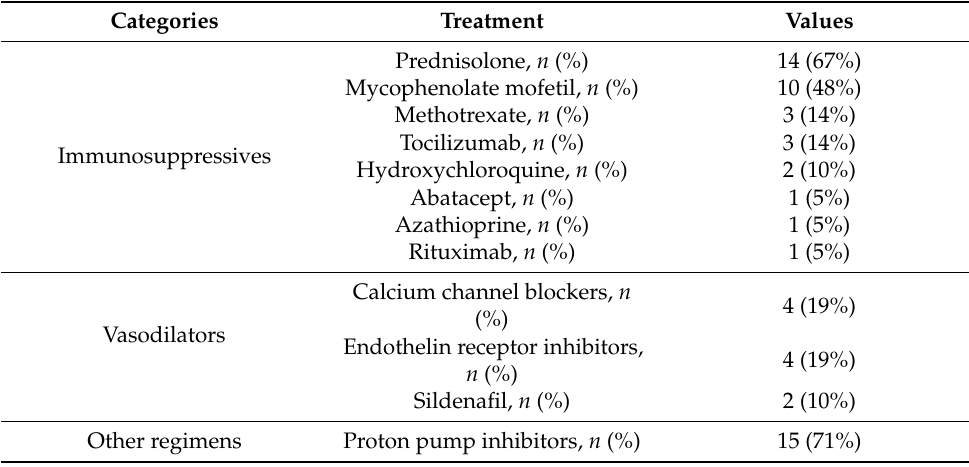
Table 2. Types of concomitant